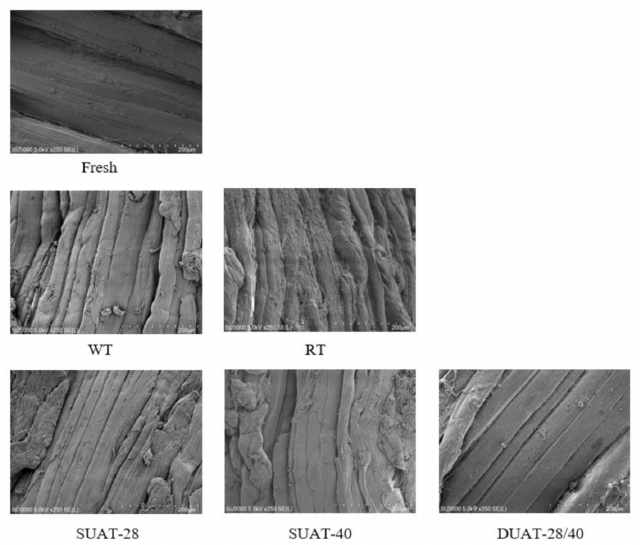
Figure 6. Differences in scanning electron microscope image of large yellow croaker under different thawing methods and fresh sample. (WT: water thawing; RT: refrigerated thawing; SUAT-28: single- frequency ultrasound-assisted thawing at 28 kHz; SUAT-40: single-frequency ultrasound-assisted thawing at 40 kHz; DUAT-28/40: dual-frequency ultrasound-assisted thawing at 28 kHz and 40